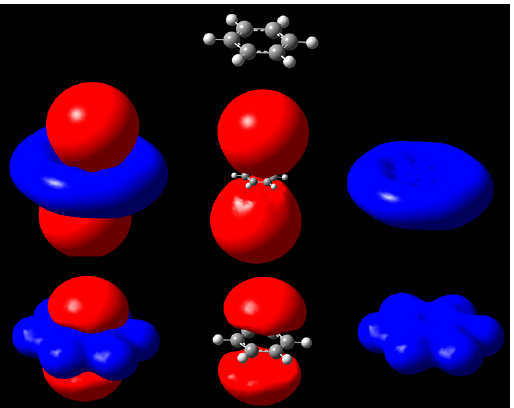
Figure 2. Isopotential surfaces of benzene, separated between negative (red) and positive (blue) regions corresponding to the same absolute value of potential. Isopotential pairs are ±0.03 (second row) and ±0.3 V (bottom). A molecule is depicted for position reference.